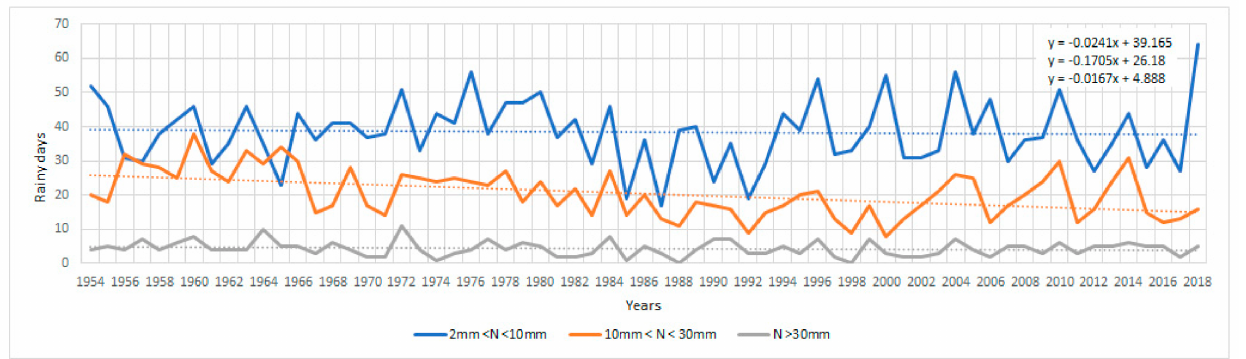
Figure 11. Total annual number of rainy days > 2 mm, > 10 mm and <30 mm, and <30 during